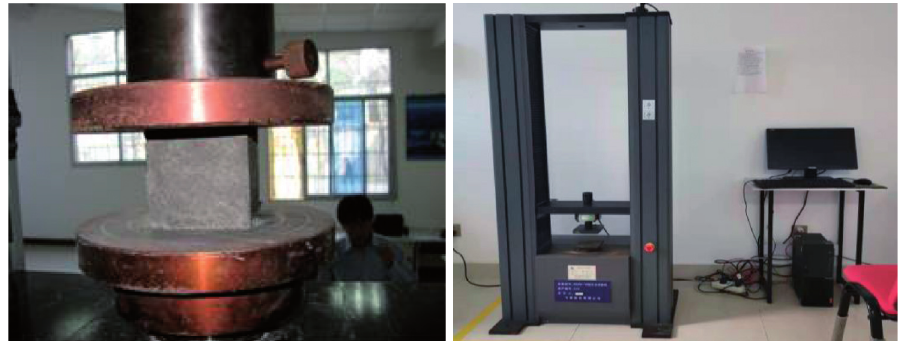
Figure 6: Laboratory UCS